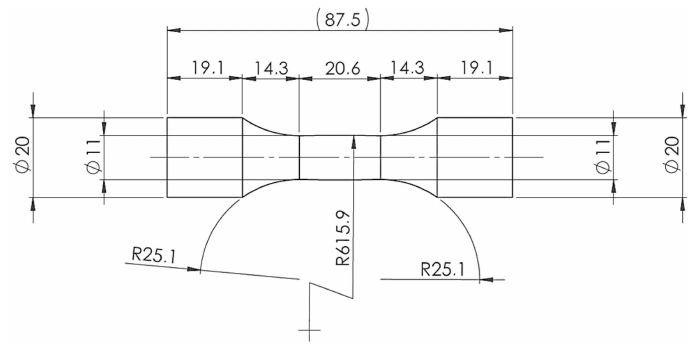
Figure 1. Geometry of the Gaussian specimen.